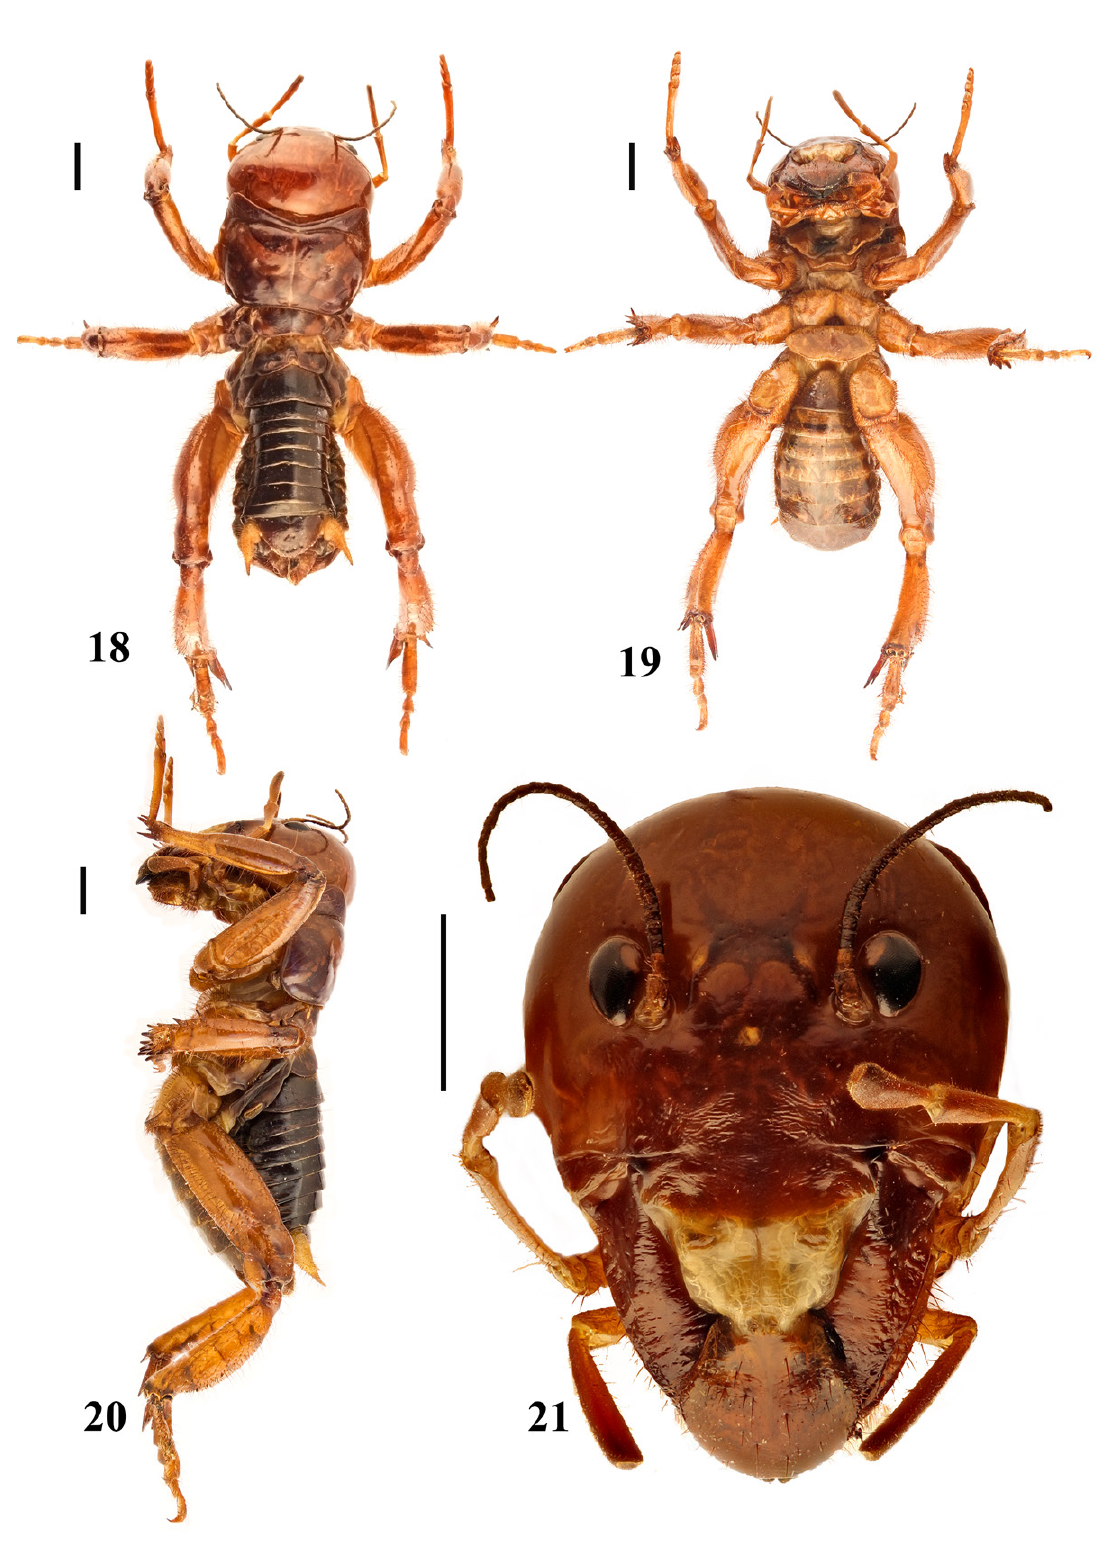
Figs 18–21. Oryctopterus varuna sp. nov. Paratype, ♀ (NBAIR). 18 . Dorsal habitus. 19 . Ventral habitus. 20 . Lateral habitus. 20 . Head, frontal view. Scale bars = 5